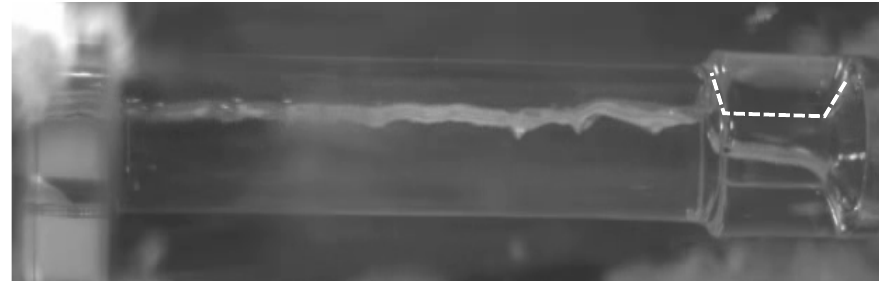
Figure 11. Smooth stratified flow upstream of the orifice.